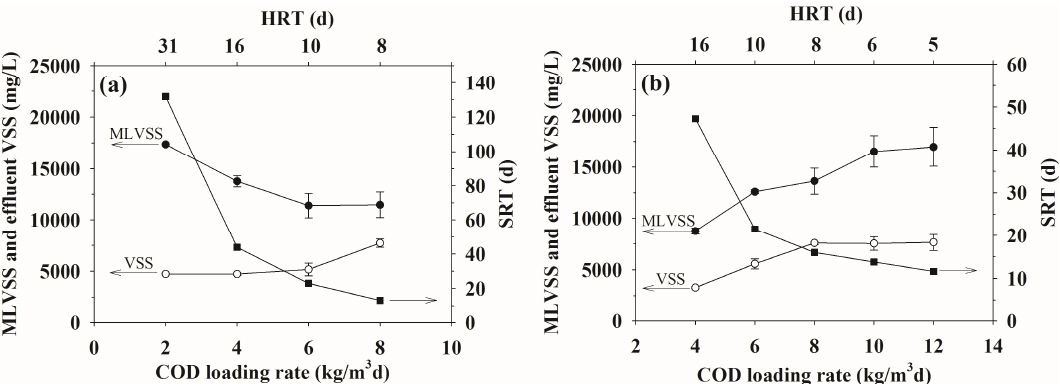
Figure 4. The microbial concentration (MLVSS), effluent volatile suspended solids (VSS) and solids retention time (SRT) at different COD loading rates and HRT in the ASBR operated under a ( a ) mesophilic (37 °C) or ( b ) thermophilic (55 °C) temperature. Data are shown as the mean ± 1SD, derived from 5 independent repeats.